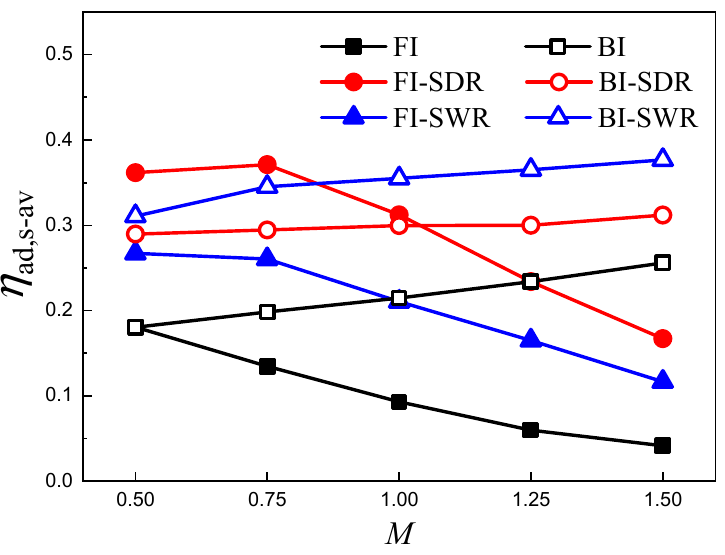
Figure 16. Spatially averaged adiabatic film cooling effectiveness.